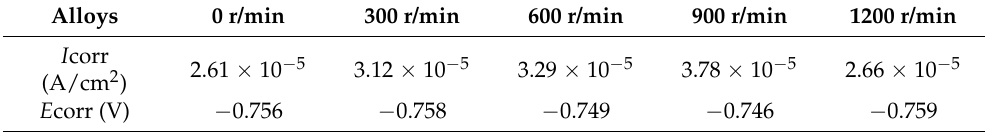
Figure 10. Potential dynamic polarization curves of the Ag–1.5Cu–1.0Y alloys under different rotation speeds ( a ). Zoom in the area between − 0.70 and − 0.80 V vs. Hg/HgO ( b ). Table 4. Potential dynamic polarization test of the Ag–1.5Cu–1.0Y alloys with different rotation speeds.